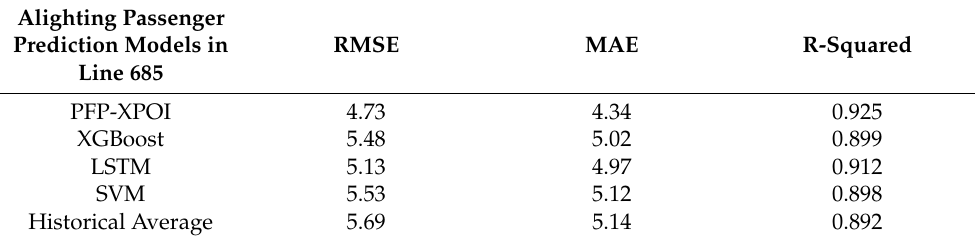
Table 5. Evaluation values of different models for alighting passenger prediction in line